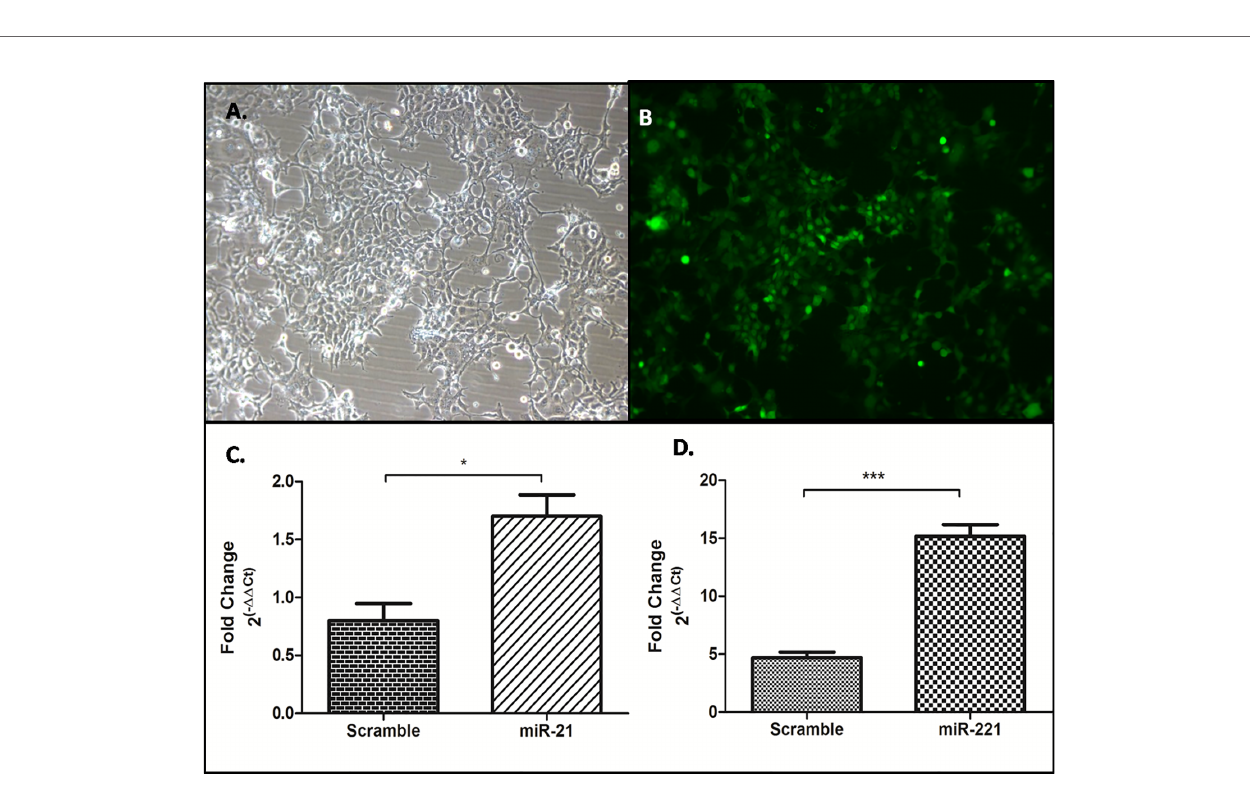
FIGURE 7 | Generation of stable cell line overexpressing miR-21, -221, and miR-Scr. Stable selection of Huh7 cell lines were carried out by zeocin selection (A) and con fi rmed by reporter GFP expression (B) , Overexpression of miR-21 (C) , and miR- 221 (D) compared to miR-Scr was checked by miR speci fi c SYBR green based real time PCR after normalization with U6 snRNA. (*P ≤ 0.05), (***P ≤ 0.0001).